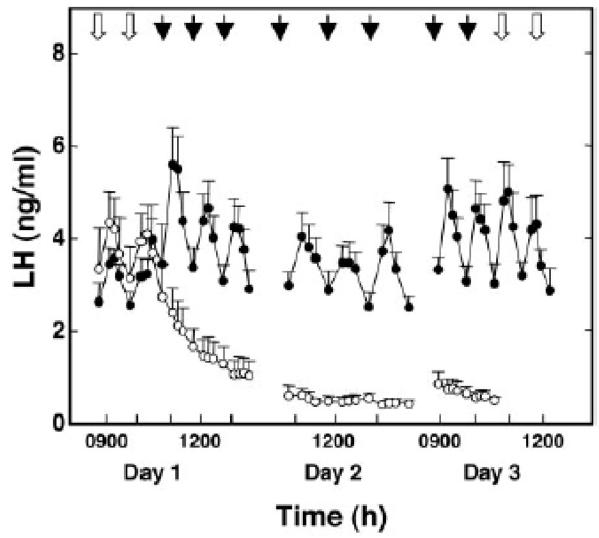
Figure 2. Intermittent kisspeptin administration drives a corresponding pattern of GnRH dependent luteinizing hormone discharges in monkey. Intermittent intravenous administration of kisspeptin-10 (2 μg/min for 1 min/hour starting at 11 a.m. on day 1 and continuing for 48 hours, closed data points) induces a sustained train of luteinizing hormone (LH) “pulses” in a naturally GnRH-deficient primate model (juvenile male rhesus monkey) that matches that generated by an antecedent intermittent GnRH infusion, also administered at 1 pulse/hour before kisspeptin administration (9 to 11 a.m., day 1). The LH response to kisspeptin was abolished by prior treatment with a GnRH receptor antagonist (not shown). Results for vehicle are shown in the open data points. Although kisspeptin-10 or vehicle was administered every hour for 48 hours, LH responses were tracked for only two or three pulses per day. Black arrows indicate times of pulse infusions of kisspeptin-10 or vehicle that were selected for monitoring the LH response. White arrows indicate time of GnRH pulse infusions. Values are presented as mean ± standard error. GnRH, gonadotropin-releasing hormone. Reproduced from Plant et al . 32 with permission of the Endocrine